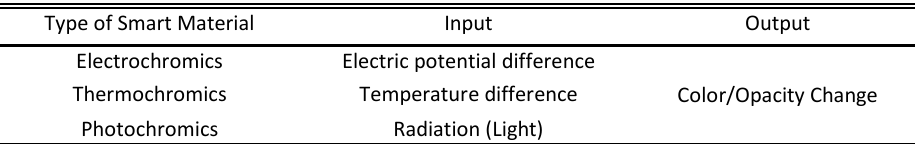
Table 1 Color and optically changing smart material types in relation to input and output stimuli (Addington and Schodek,